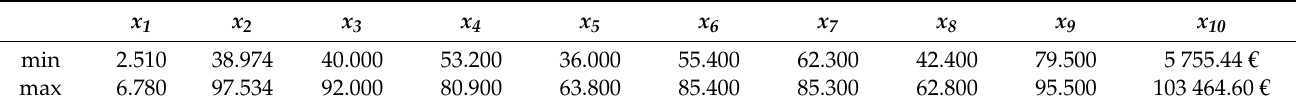
Table 10. Optimization constraints for input variables x 1 to x 10 in natural scale.